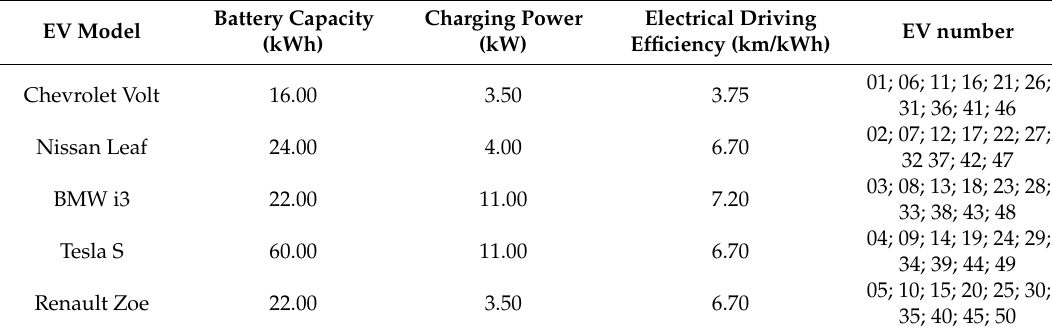
Figure 5. Hourly electricity prices. Table 2. Electric Vehicle (EV) features under analysis.